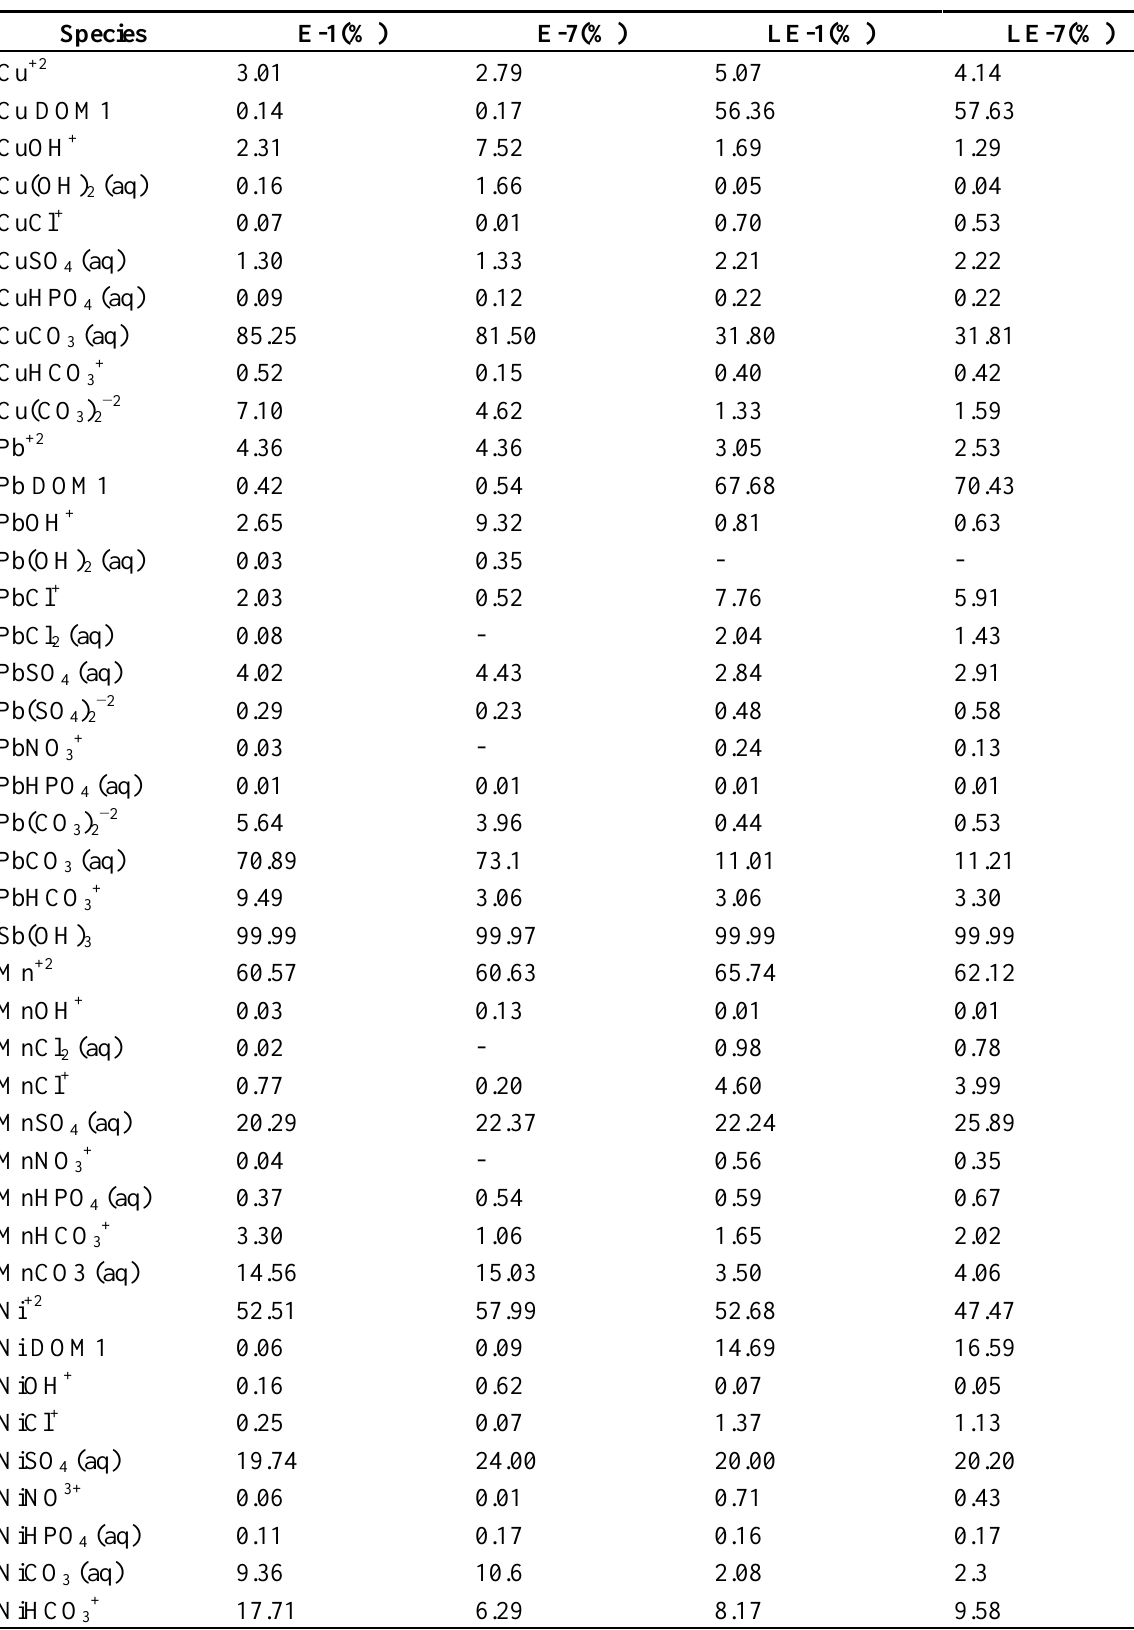
Table 6. Distribution of species in leachates of soils and slags (E-1, E-7) and leachates of amended materials (LE-1, LE-7) in the pilot-scale